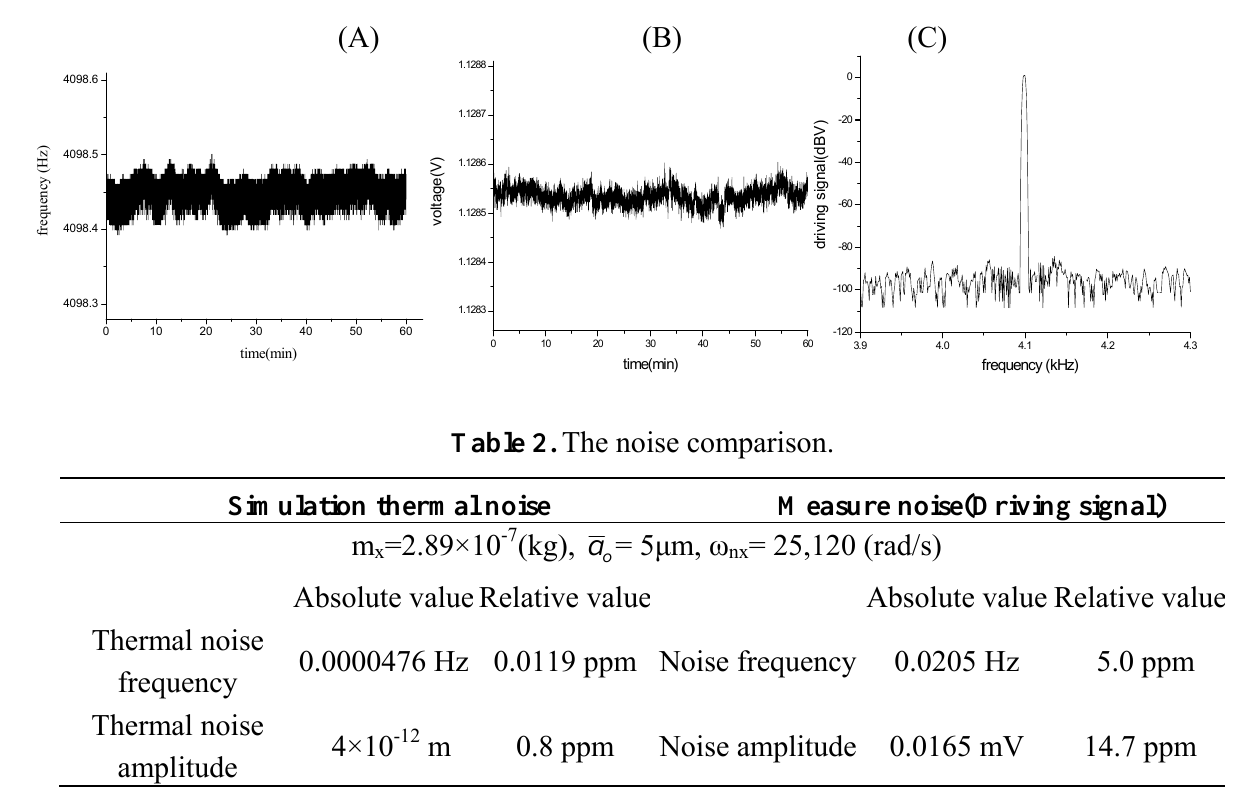
Figure 13. The experiment results of closed-loop driving .(A) Frequency drift of driving signal for 1 h. (B) Amplitude drift of driving signal for 1h. (C) Frequency spectrum of driving signal.